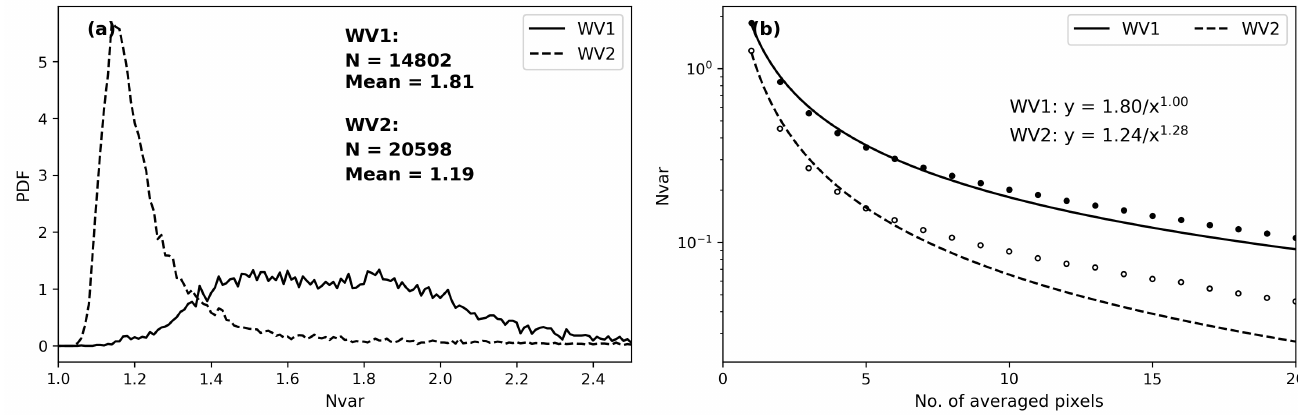
Figure 2. ( a ) PDF of Nvar at the original pixel resolution. ( b ) Variation of Nvar relative to the number of averaged pixels. The scatter was calculated based on a SAR case example; the curves are the regression lines with the mathematical format annotated in the